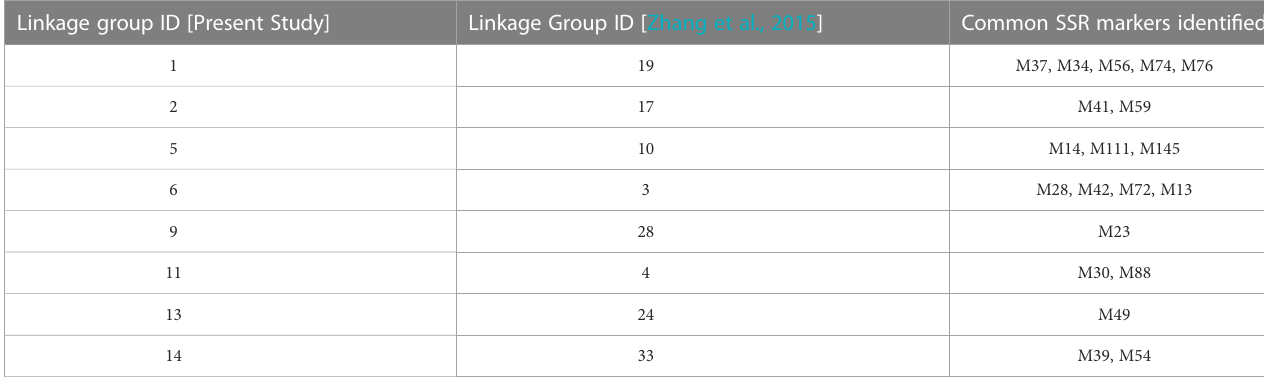
TABLE 2 Genetic linkage group commonality for S.japonica in the present study and in Zhang et al., 2015. Linkage group ID [Present Study]